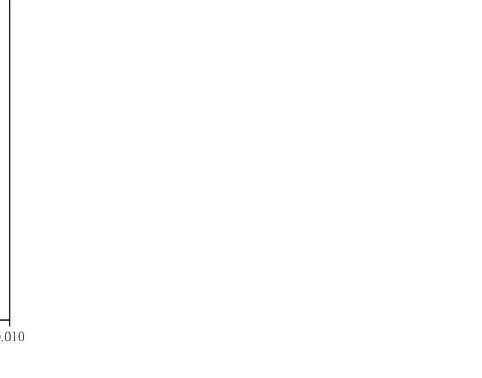
Figure 6. Comparison of simulation and experiment. The simulated failure mode of the grouting material is compared with the experi- mental one. The tensile damage cloud diagram and the image of experiment are shown in Figure 7. ( a ) ( b ) Figure 7. Comparison of the cloud diagram of grout’s tensile damage with the experimental damage. ( a ) Cloud diagram of tensile damage. ( b ) Comparison of fracture morphology. In Figure 7, the simulated fracture morphology, position and cracking angles are co- incident with that of the test. The load-displacement curve and failure pattern of the